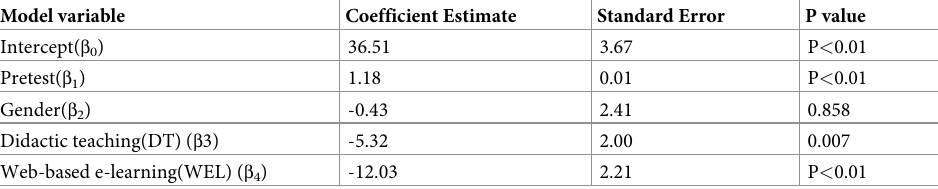
Table 3. Multiple linear regression demonstrating the relationship of total score with other